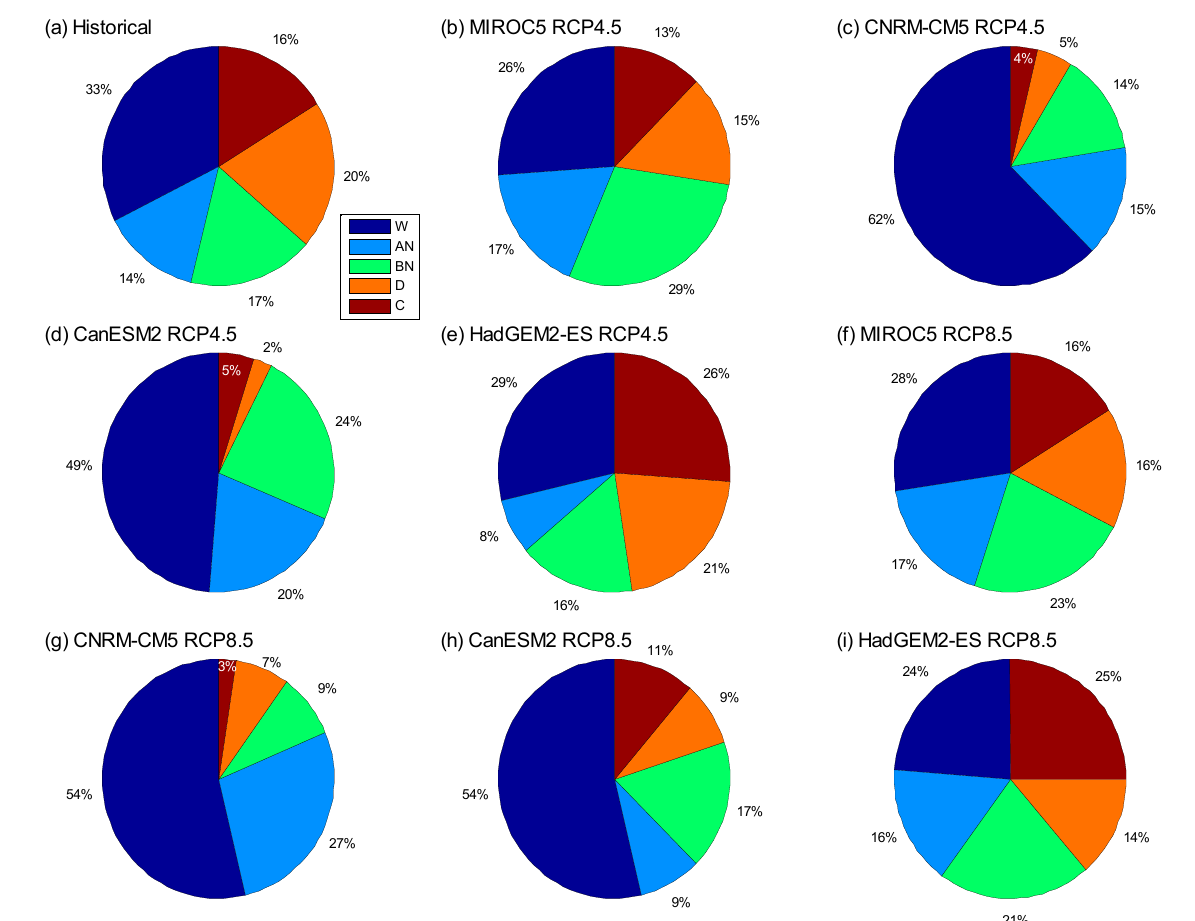
Figure 4. Historical and projected water year type distribution of SAC4. The “cool/wet” (CNRM ‐ CM5) projection and “average” (CanESM2) projection are strikingly different from that of the “complement” projection and “warm/dry” projection.